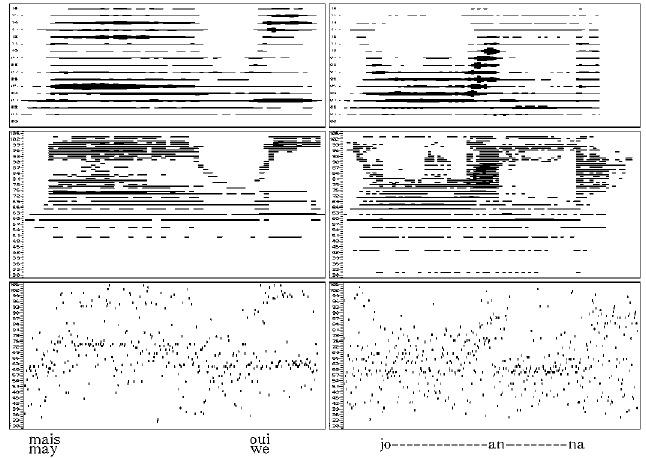
Figure 7: “mais oui, Joanna”: sonagramme (top), MIDI pitch-time maps of synthrumentation (middle) and spectastisation